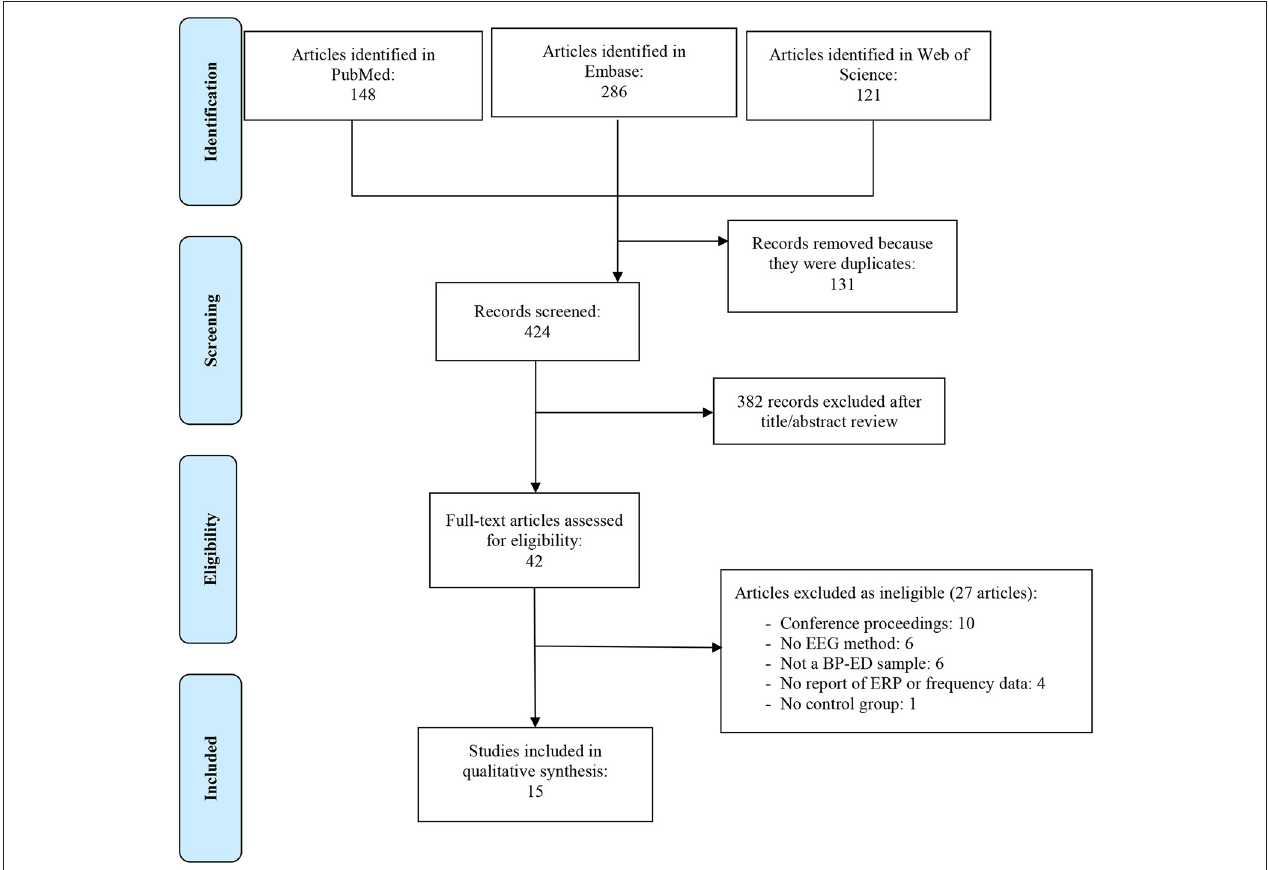
FIGURE 1 | PRISMA flow